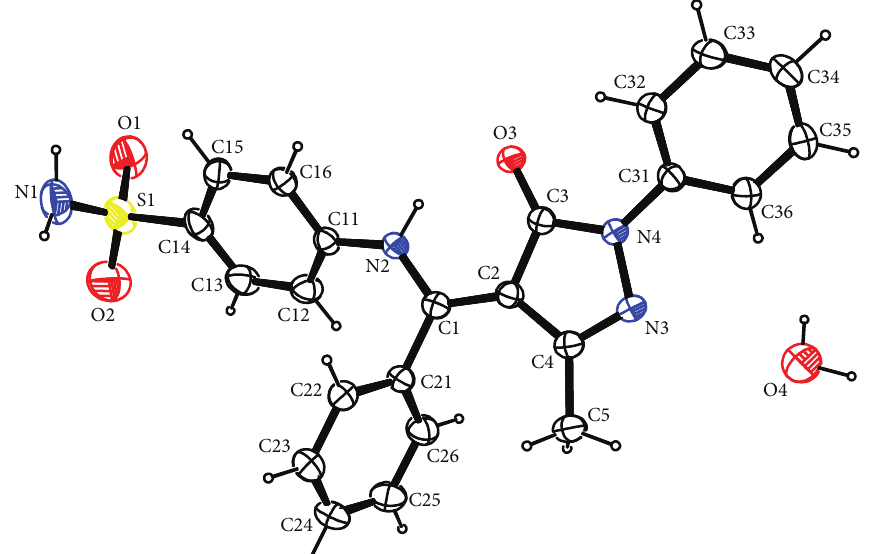
Figure 13: Molecular crystal structure of Bmpp-Sn ⋅ H 2 O.